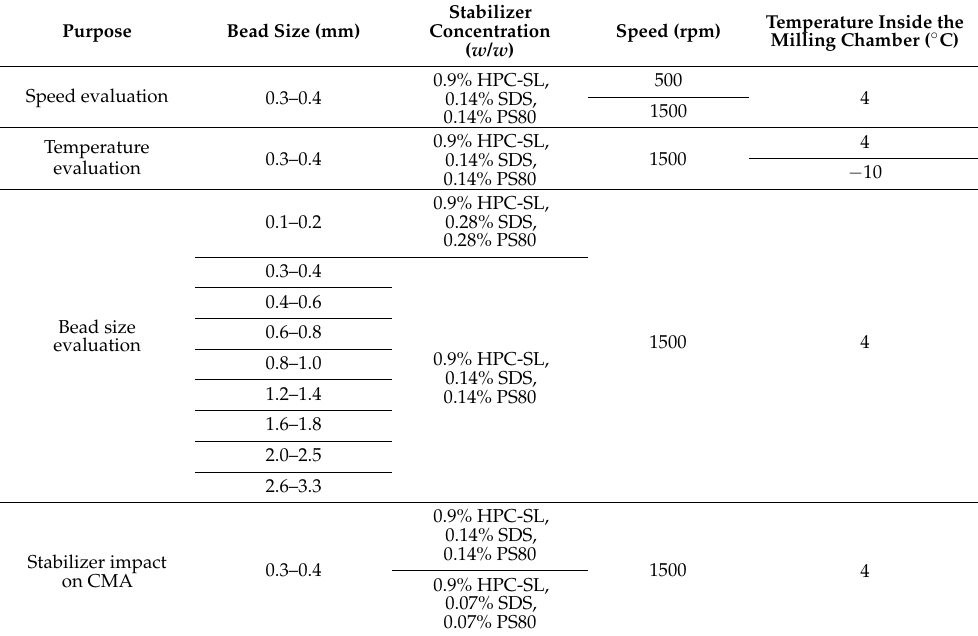
Table 1. Overview of the parameters for the evaluation of the milling process. HPC-SL: hydrox- ypropyl cellulose, SDS: sodium dodecyl sulfate, PS80: polysorbate 80. Purpose Bead Size